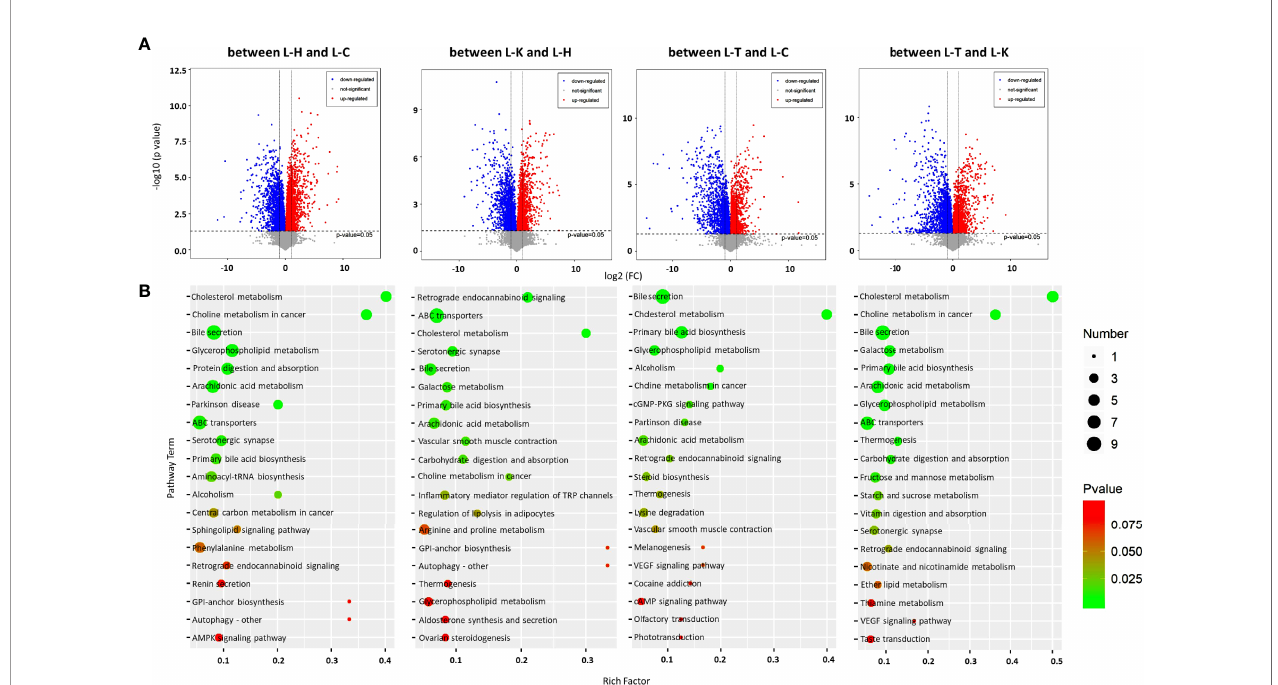
FIGURE 6 | Metabolomic analysis of the rat livers. (A) Volcano plots were prepared by plotting the log (base 2) of the FC and p values of t-test results (base 10) for differentially expressed metabolites in rat livers between pairs of the four groups including the healthy control (L-H) (n=6), CIA rats (L-C) (n=6), CIA rats treated with 2- DG (L-T) (n=6), and healthy rats treated with 2-DG (L-K) (n=6). (B) The pathway analysis was performed based on the KEGG pathway database. The bubble chart shows the pathways that were enriched with DEMs in the liver between the four rat